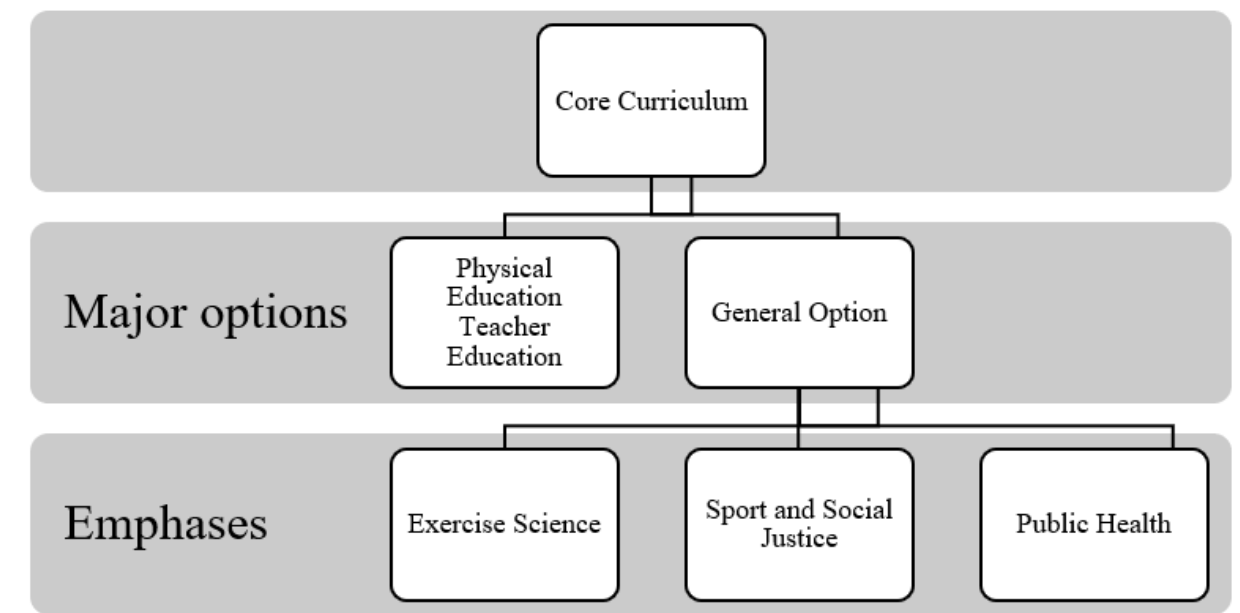
Figure 1. Revised KHP curriculum options and emphases.